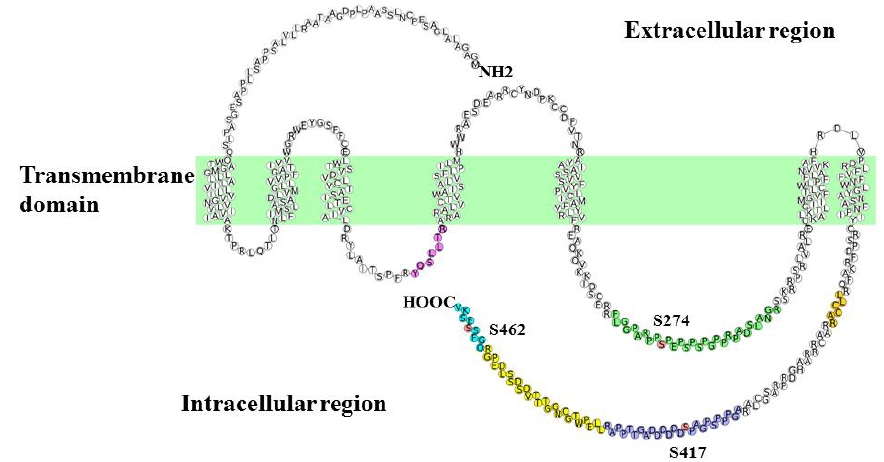
Figure 4. Schematic representation of mouse Adrb1 showing the location of identified tryptic peptide fragments. In total, six Adrb1-derived tryptic peptide fragments located in the third intracellular loop and the C-terminus of the receptor were identified. Each peptide fragment is shown as colored circles, with FLGGPARPPSPEPSPSPGPPRPADSLANGR as green, AGPPPSPGAPSDDDDDDAGTTPPAR as purple, LLEPWTGCNGGTTTV DSDSSLDEPGR as yellow, QGFSSESKV as cyan, LLCCAR as orange, and YQSLLTR as magenta. Phosphorylated residues are shown in